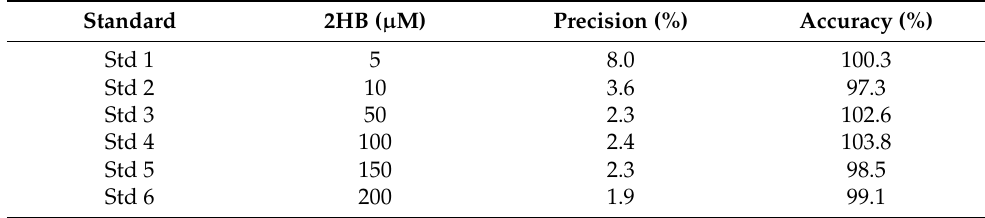
Table 1. Inter-day precision and accuracy values of the calibration curve standards ( n = 5). Standard